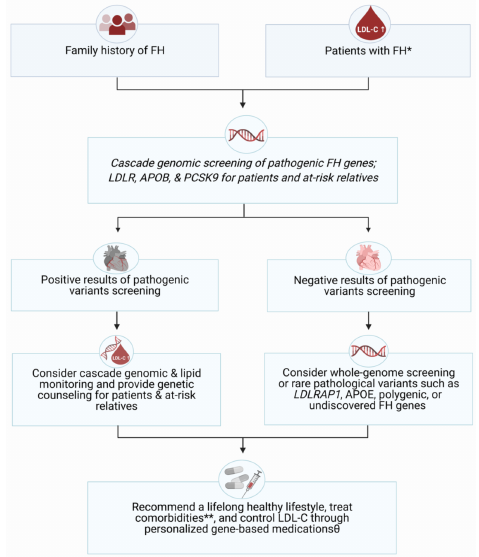
Figure 3. Flowchart illustration of the recommended genomic screening process for different groups of FH patients and their families (generated with BioRender.com). * Diagnostic Criteria of FH based on Dutch-MEDPED guideline: total cholesterol > 250 mg/dL, LDL-C > 190 mg/dL (adults) or >160 mg/dL (children), in addition to family history of similar findings or with premature cardiovascular diseases, tendon xanthomas, arcus cornealis, or DNA-based evidence of LDLR, APOB